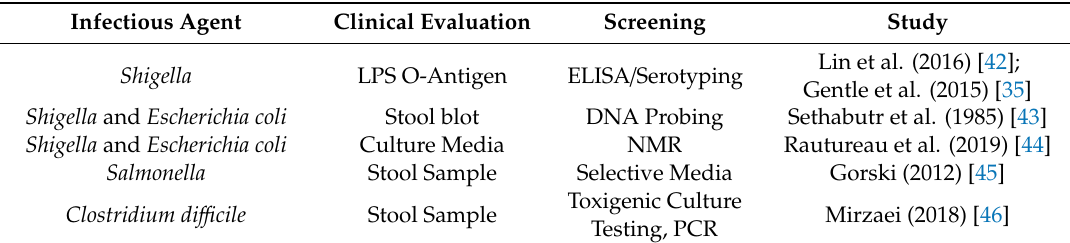
Table 2. Potential infectious agents of gastrointestinal